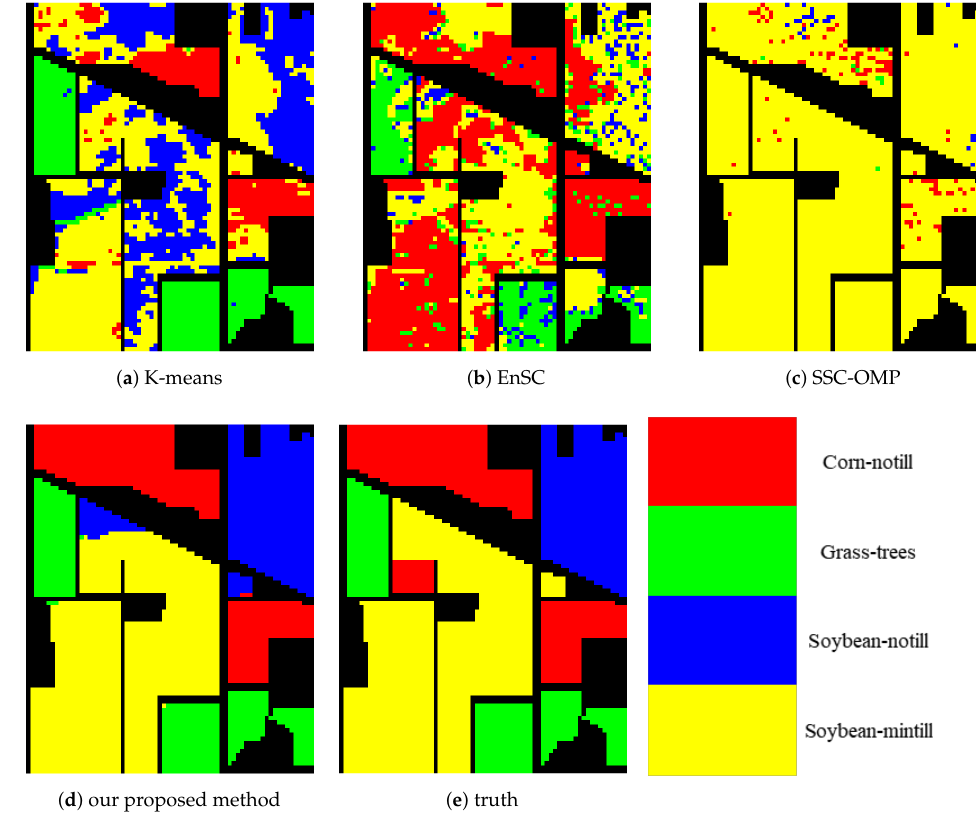
Figure 6. The clustering results achieved by different methods on the Indian Pines